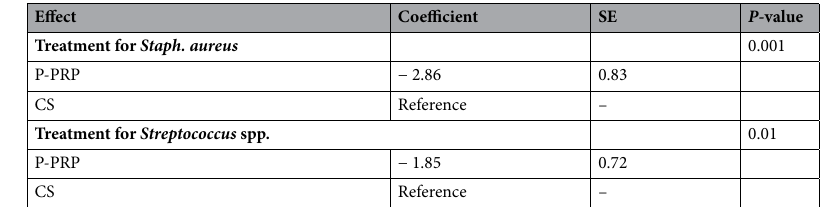
Table 4. Coefficients and standard error (SE) of the logistic regression model for evaluating the effect of intramammary treatments (10 mL of P-PRP and 75 mg of CS for three consecutive milkings) on the probability of cure in cows infected with Staphylococcus aureus and Streptococcus spp. (includes only Streptococcus uberis , Streptococcus agalactiae and Streptococcus dysgalactiae ). CS cefquinome sulfate, P-PRP pure platelet rich plasma, SE standard error.